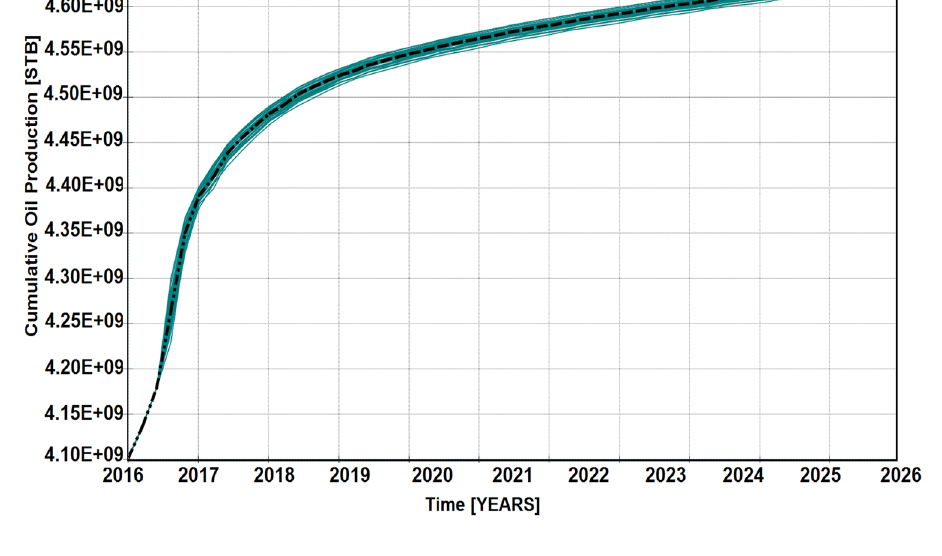
Fig. 16 Reservoir flow responses under production Huff and Puff